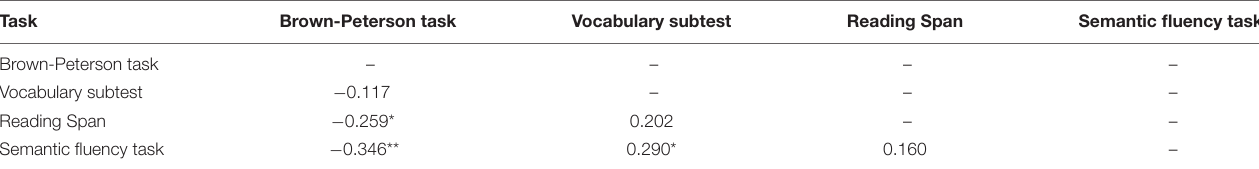
TABLE 2 | Bivariate Pearson correlations between the supplementary tasks.